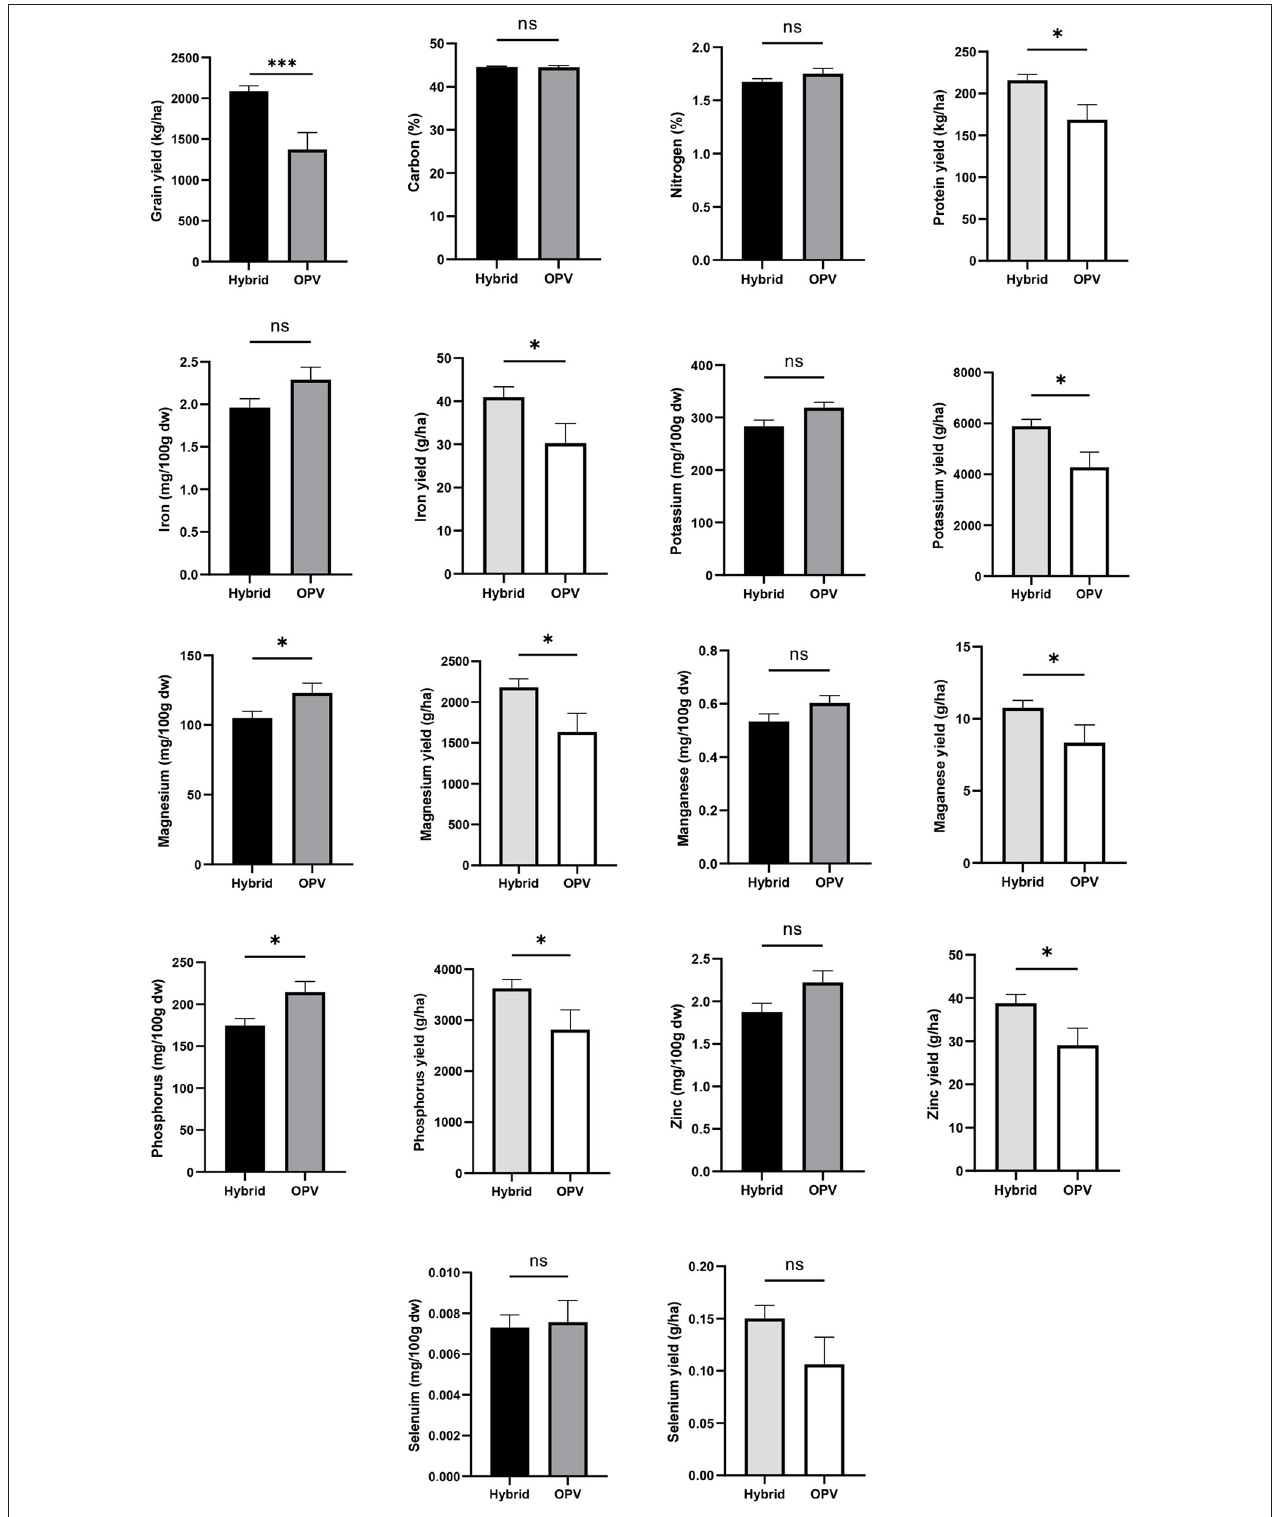
FIGURE 7 | Comparison of open-pollinated varieties and hybrid maize grown in Malawi for their grain yield, mineral content, and nutrient yield. Error bars represent SEM. ns, * and ***mean significant at 0.05 and 0.001, respectively, two-tailed unpaired t -test.